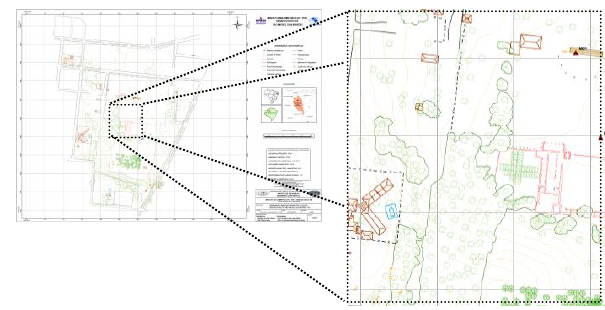
Figure 11. Map of the Archaeological Park of São Miguel